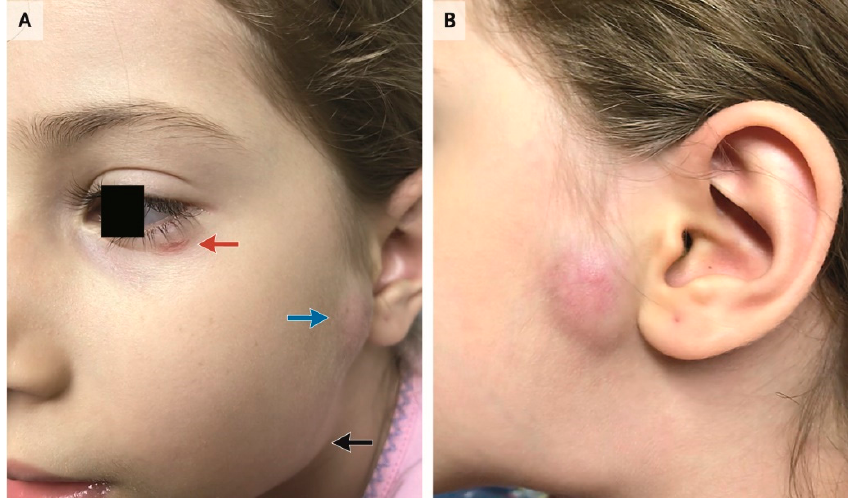
Figure 1. ( A ) Preauricular (blue arrow) and submandibular (black arrow) lymphadenopathy and excoriation below left eye (red arrow) in a 5-year old girl with cat scratch disease Parinaud’s oculoglandular syndrome (CSD POGS); ( B ) lateral view of preauricular and submandibular lymphadenopathy (case #9; [15]).